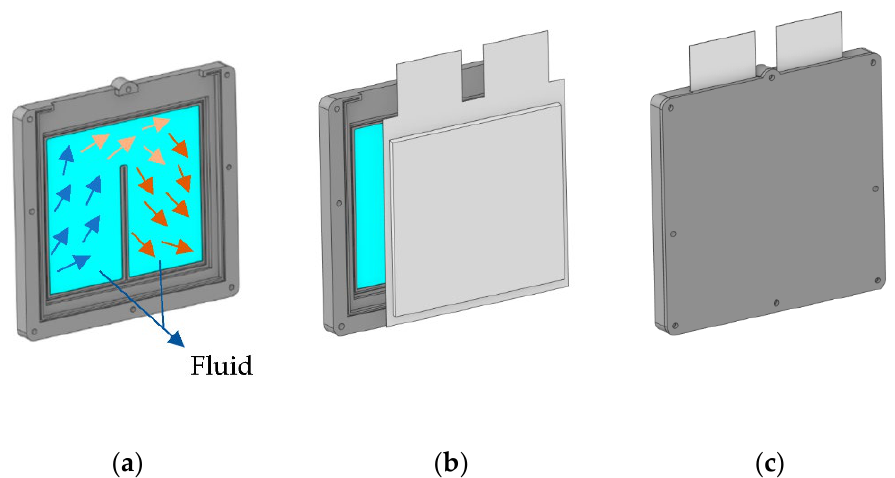
Figure 1. Reference model ( a ) flow distribution, ( b ) principal components, and ( c ) assembly.